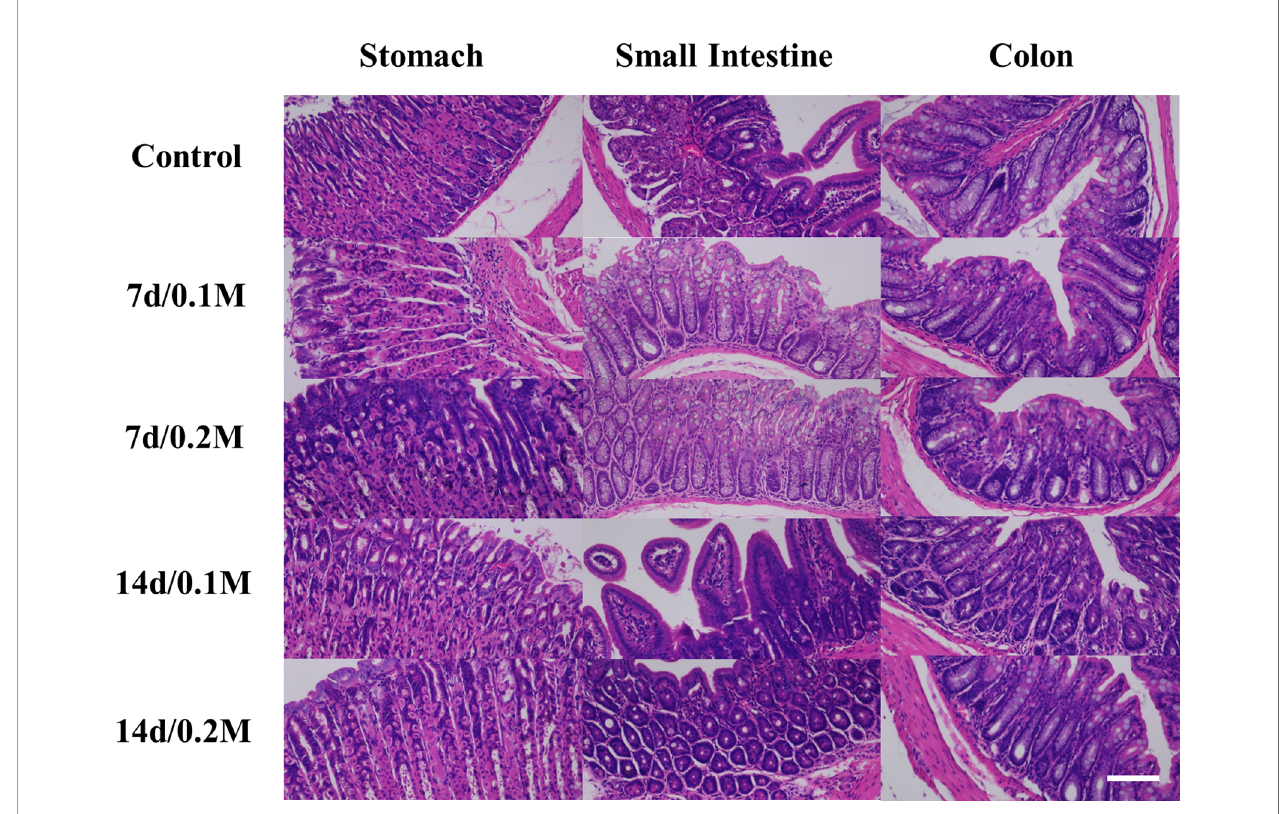
FIGURE 2 | HE staining of GI tract (stomach, small intestine, and colon) after oral administration of 200 m l of different concentrations (0.1 and 0.2 M) of Bi-DOTA after different time points (7 and 14 days) (scale bar: 200 m